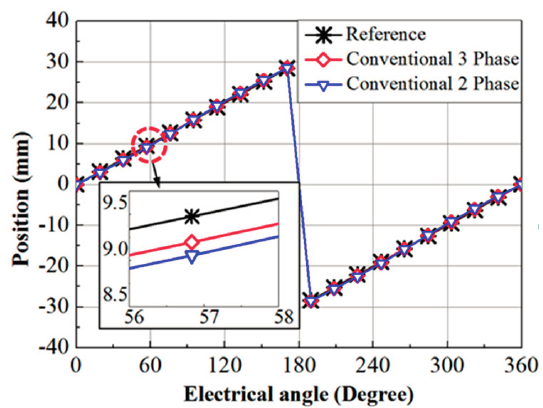
Figure 1. Simulations of the position calculation for conventional two phase and three phase sensing systems under equal amount of error in